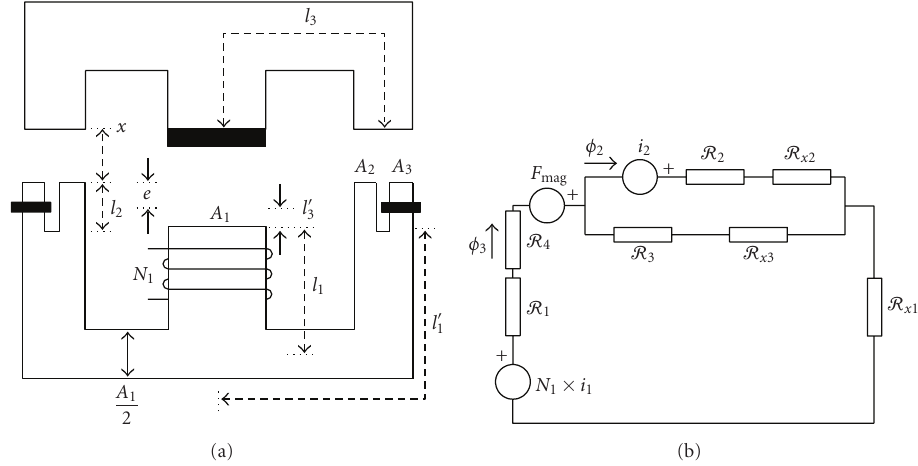
Figure 4: Developed AC PM contactor, (a) sketch of the geometry and (b) equivalent magnetic circuit.